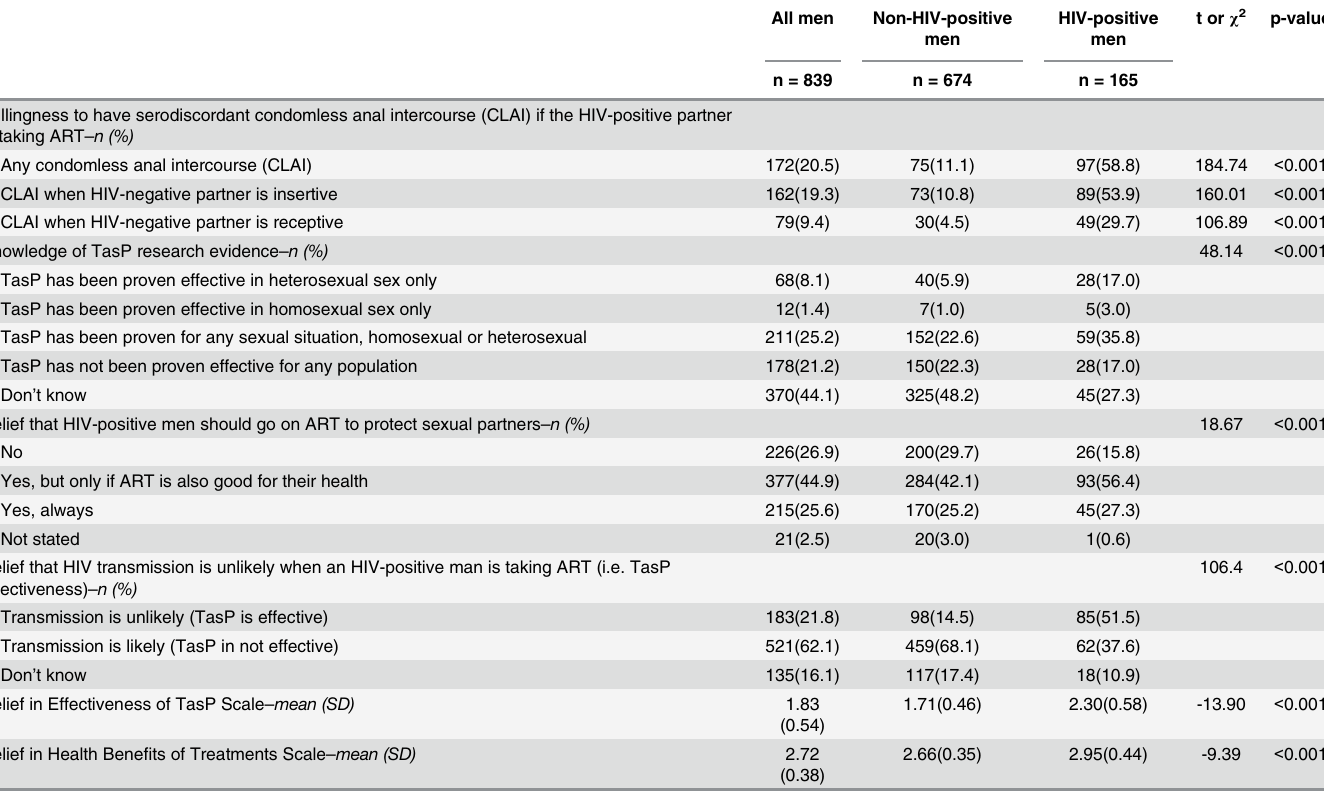
Table 2. Treatment as prevention items and scales for total sample, and comparison between HIV-positive and non-HIV-positive men (bivariate).